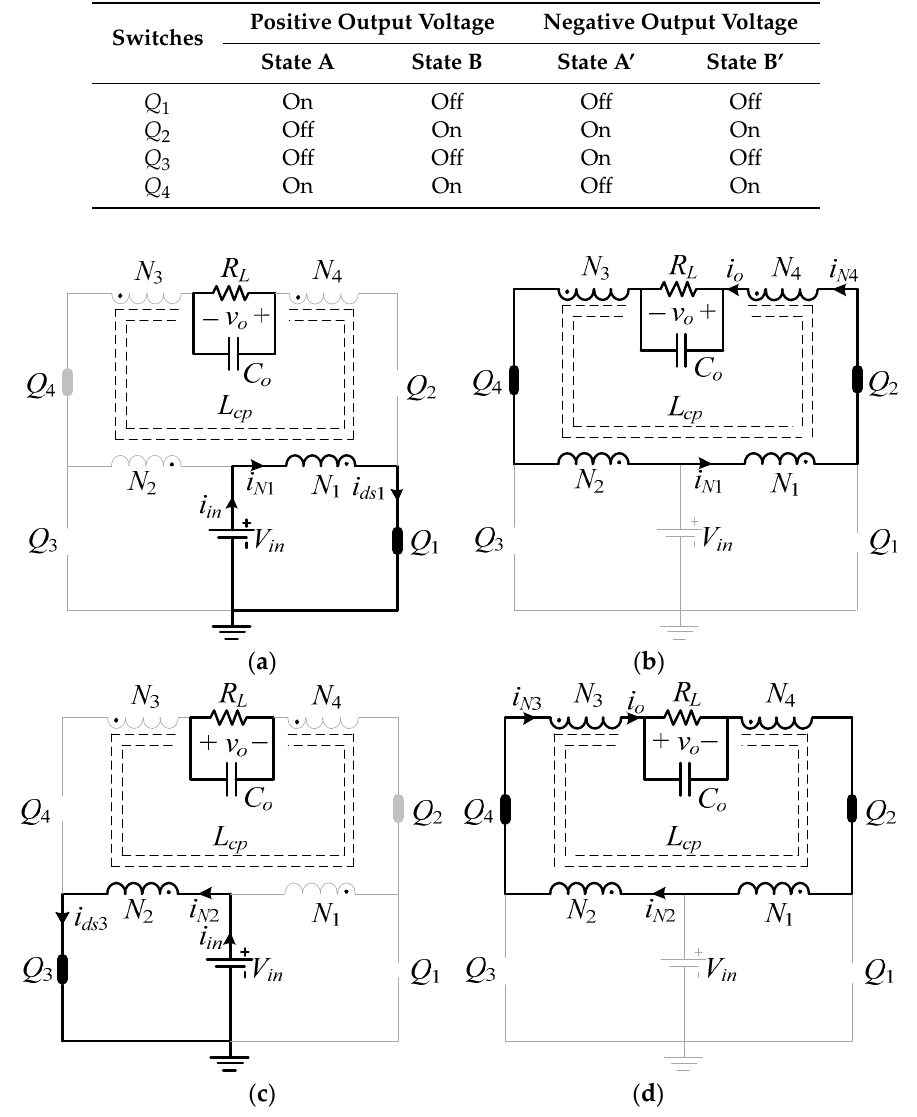
Figure 4. Equivalent circuits (switching states) of the proposed SSBBI: ( a ) State A, ( b ) State B, ( c ) State A’, ( d ) State B’.